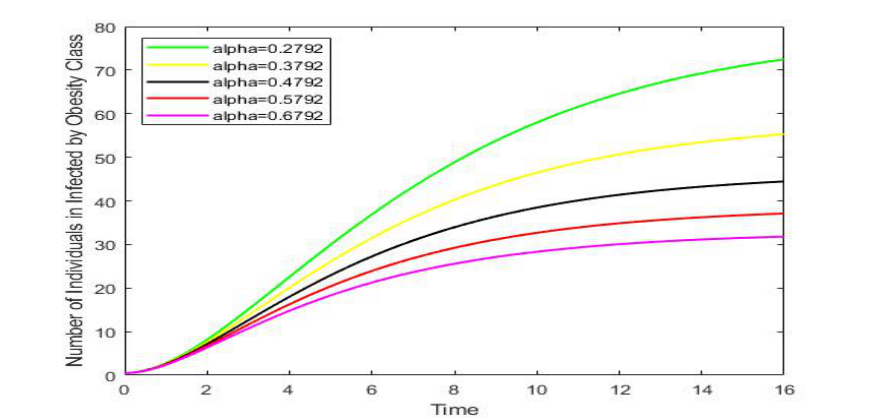
Figure 6: Infected by Obesity class for different values of α without control pa- rameters obesity rate is controlled with the control parameters.